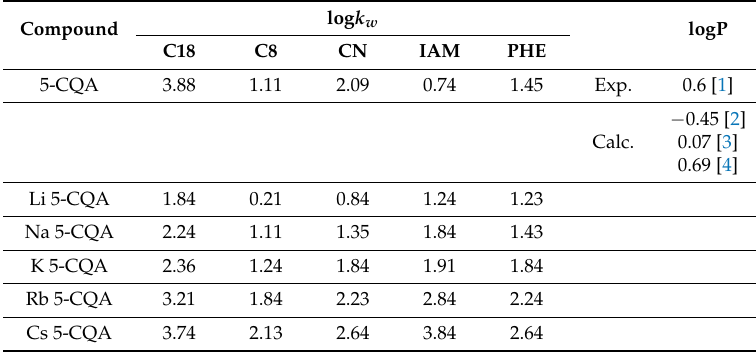
Table 5. Lipophilicity parameters determined by chromatographic methods (the logarithm of the retention factor, log k w ) and octanol/water partition coefficients logP obtained for chlorogenic acid and